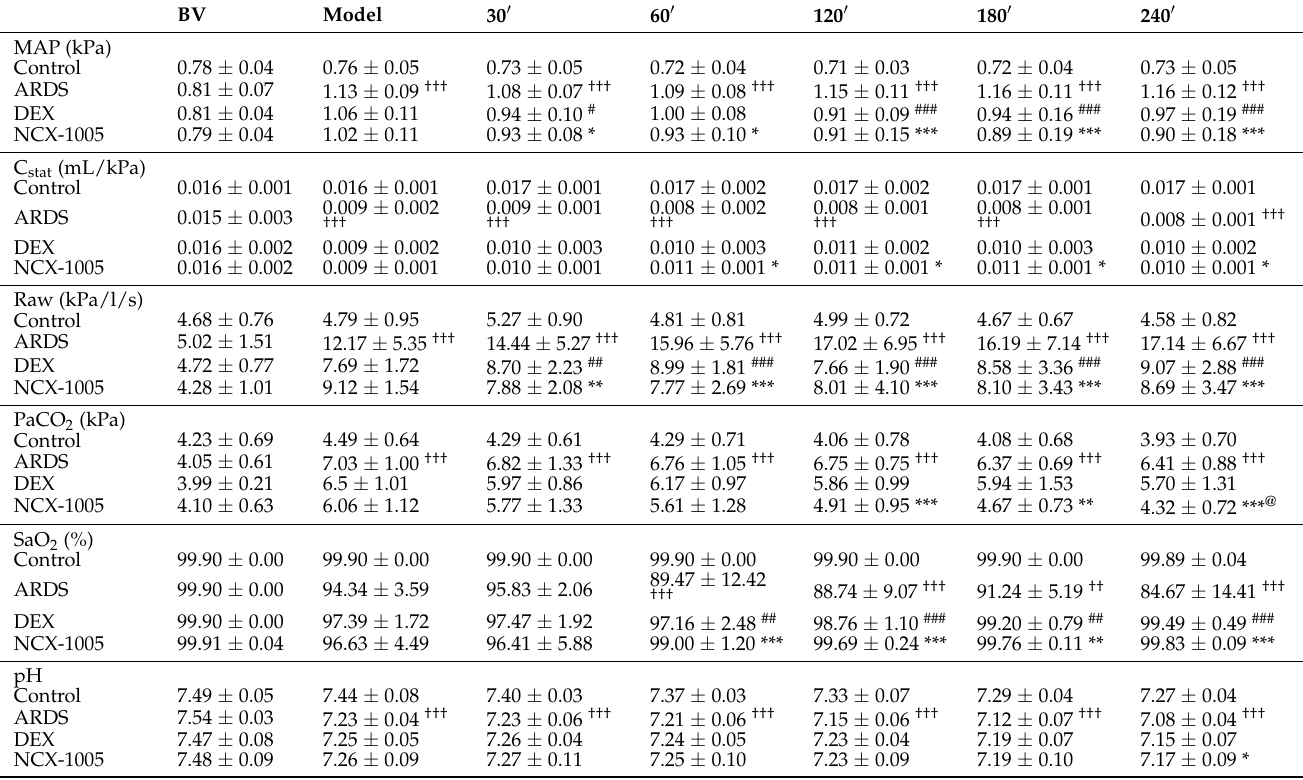
Table 1. Respiratory parameters. Mean airway pressure (MAP), static lung compliance (C stat ), airway resistance (Raw), partial pressure of carbon dioxide (PaCO 2 ), oxygen saturation (SaO 2 ), and pH before (basal value, BV) and after ARDS induction and within 4 h after therapy administration in Control group, ARDS-untreated group, and ARDS group treated dexamethasone or with NCX-1005.